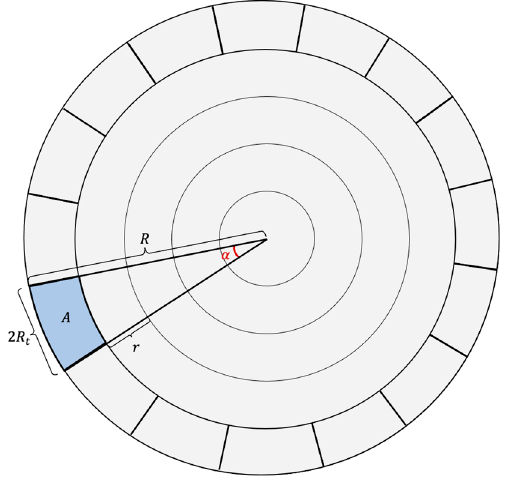
Figure 5. Partition of the last corona into regions of area A.